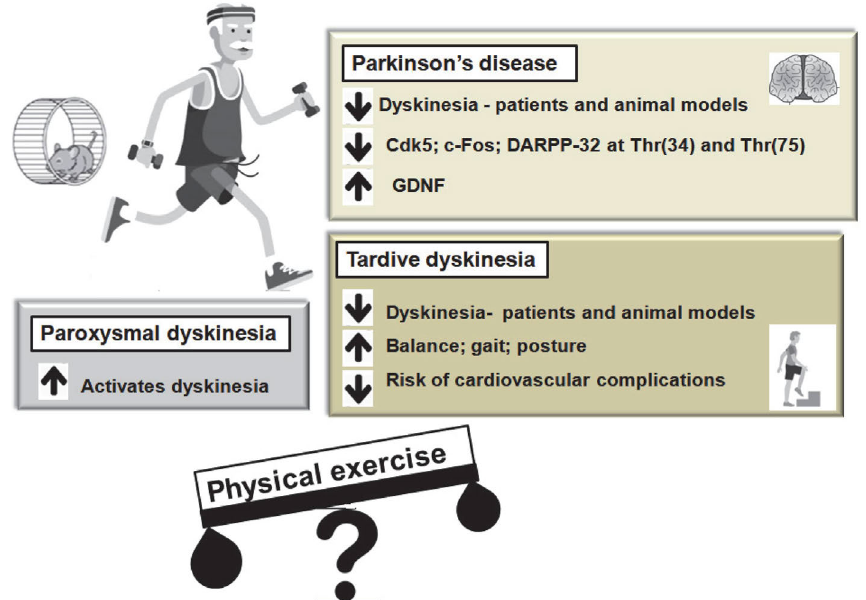
Figure 5 - Schematic drawing: Exercise has beneficial motor effects on dyskinesias in animal models and patients with Parkinson's disease or tardive dyskinesia. However, exercise can activate